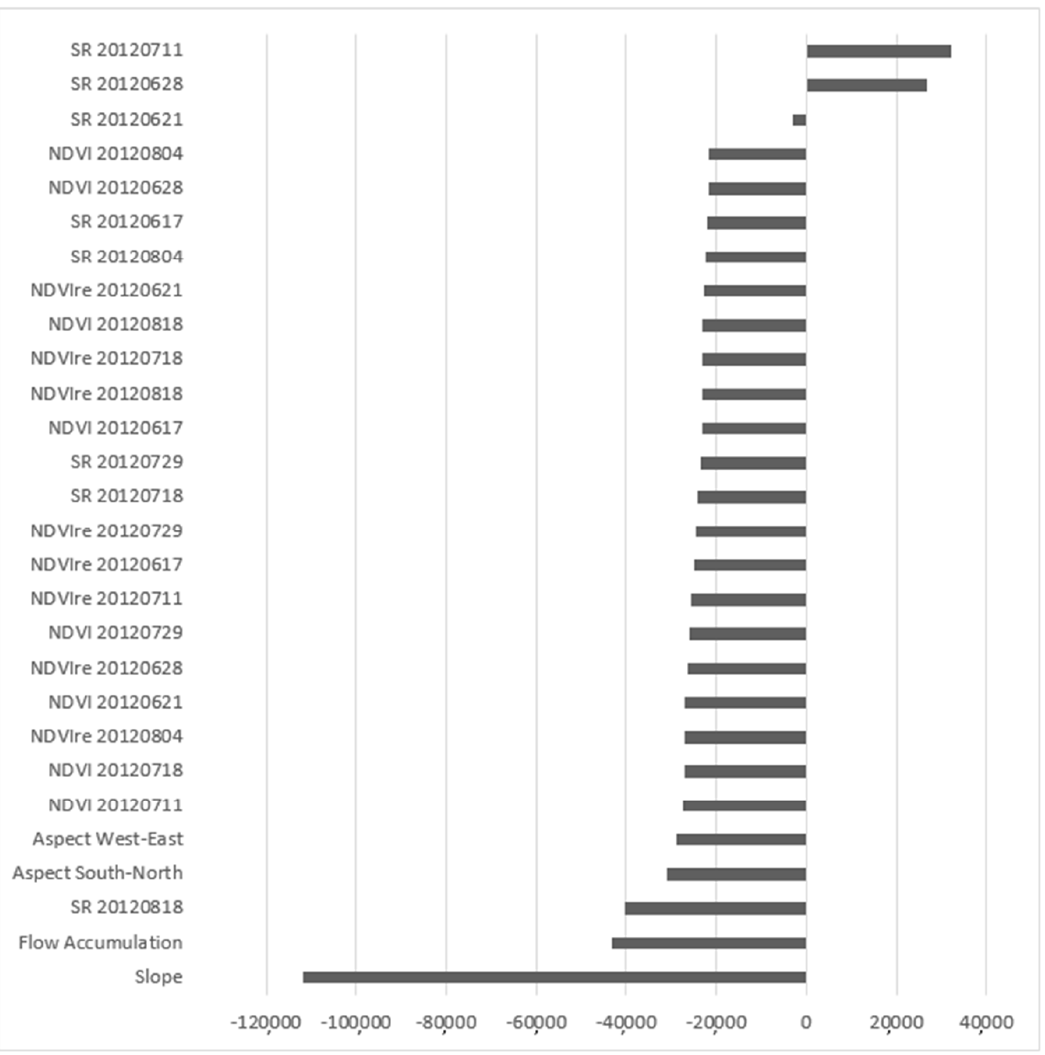
Figure A6. Importance of variables for the soybean 2012 ANN model, as measured by Connection weights (larger positive or negative values indicate higher